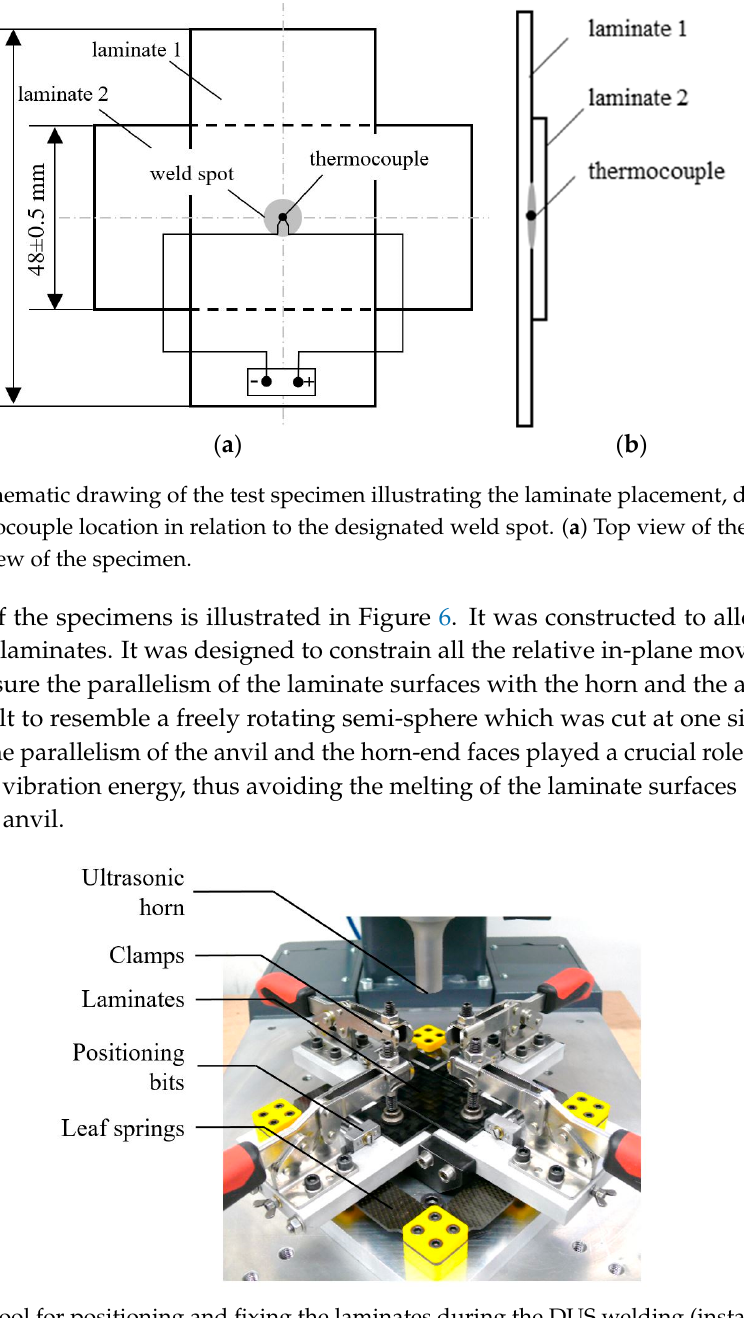
Figure 6. The tool for positioning and fixing the laminates during the DUS welding (installed on the ultrasonic welder).